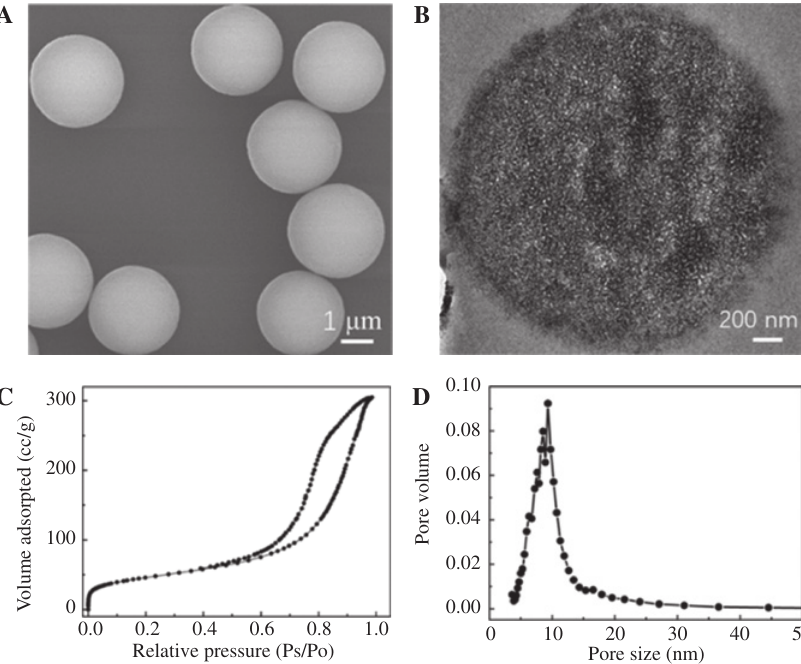
Figure 2: Characterization of the mesoporous silica microparticles. (A) SEM image of the mesoporous silica microparticles. (B) TEM image of a small broken piece of the mesoporous silica microparticle. (C) N adsorption/desorption isotherm of the mesoporous silica microparticles. (D) Barrett-Joyner-Halenda desorption pore size distribution 2 curve of the mesoporous silica